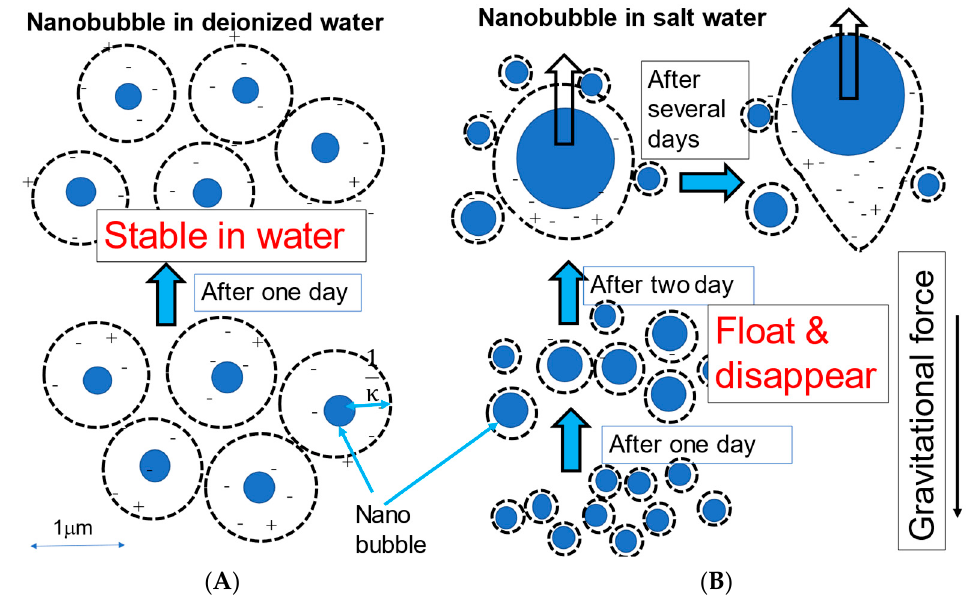
Figure 13. Schematic diagrams of nanobubble stability in deionized water ( A ) and nanobubble size change in salt aqueous solution ( B ) depending on time.